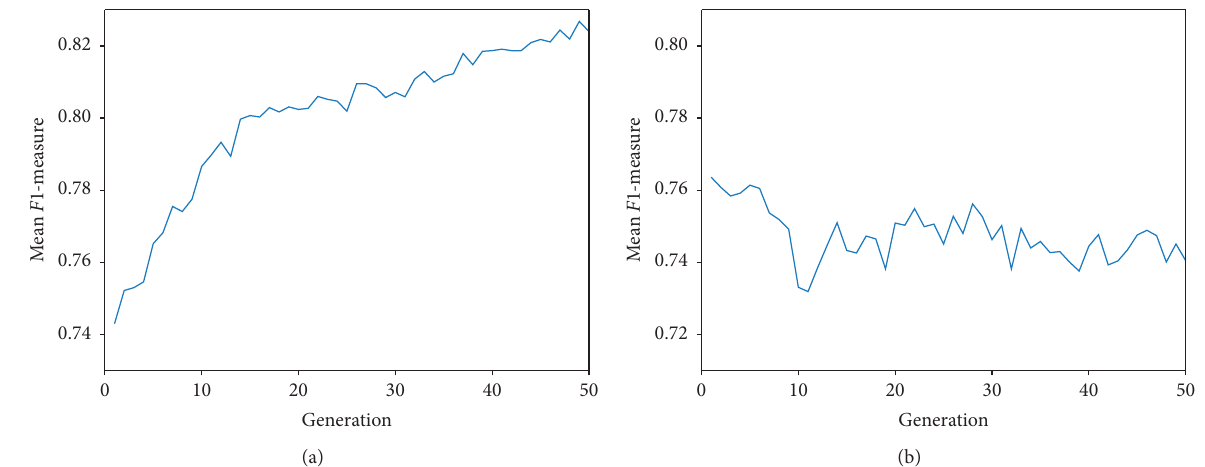
Figure 5: Using constant test set to calculate fitness. (a) Test set. (b) Verification set.